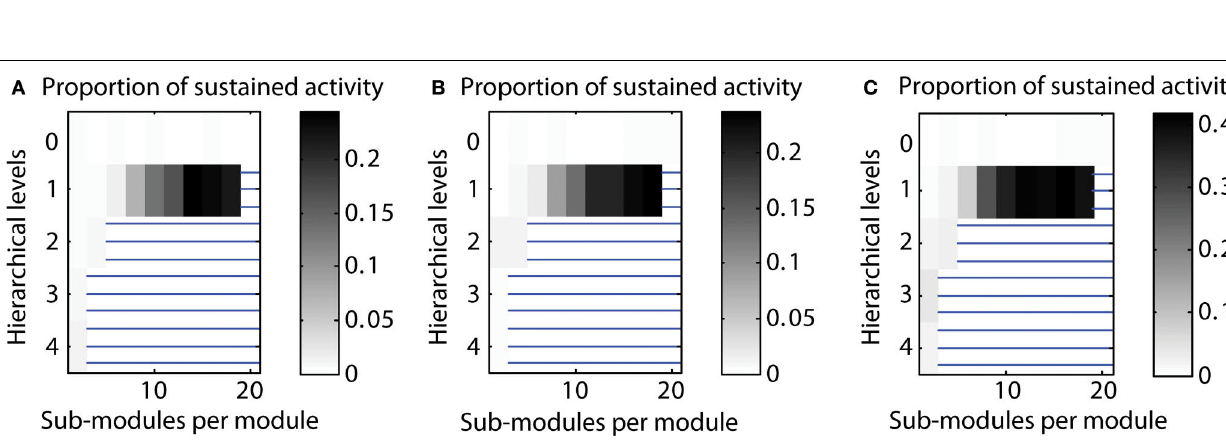
∼ (2/3) i ]. (B) Number of edges i ∼ (3/2) i ]. i